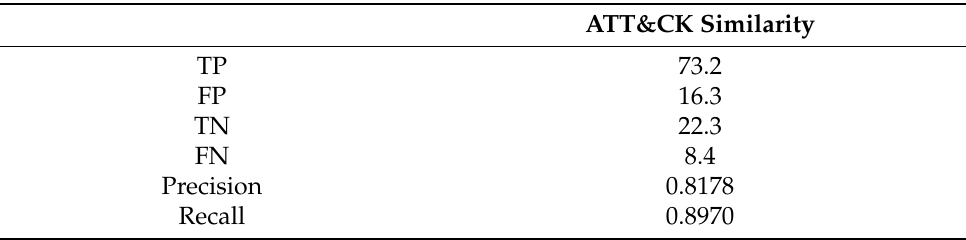
Table 2. The table represents the average recall and precision values of 12 threat actors by using ATT&CK similarity clusters. All values are rounded to the second decimal places.